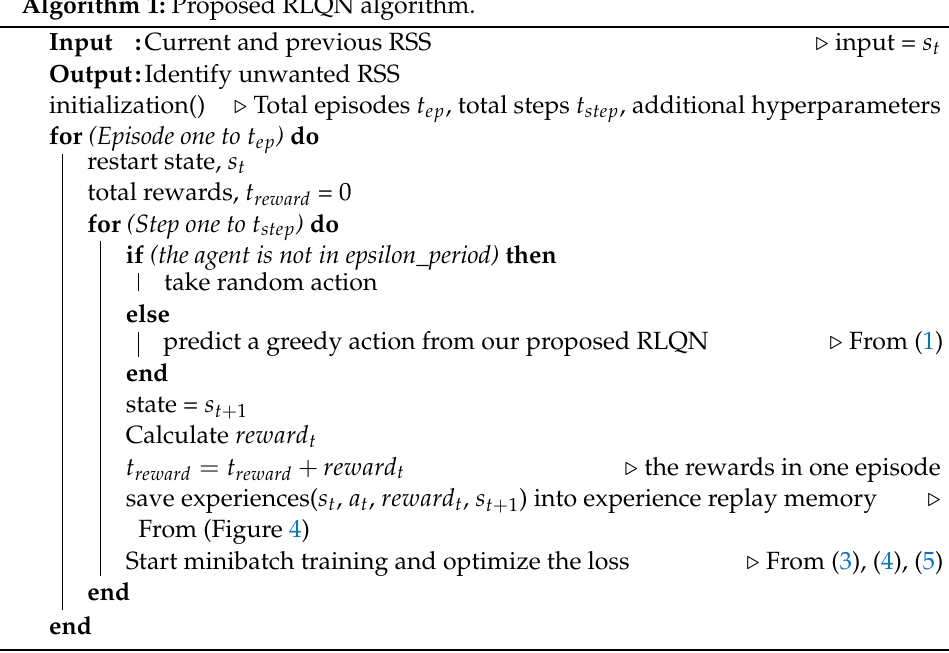
Figure 5. Proposed RLQN.